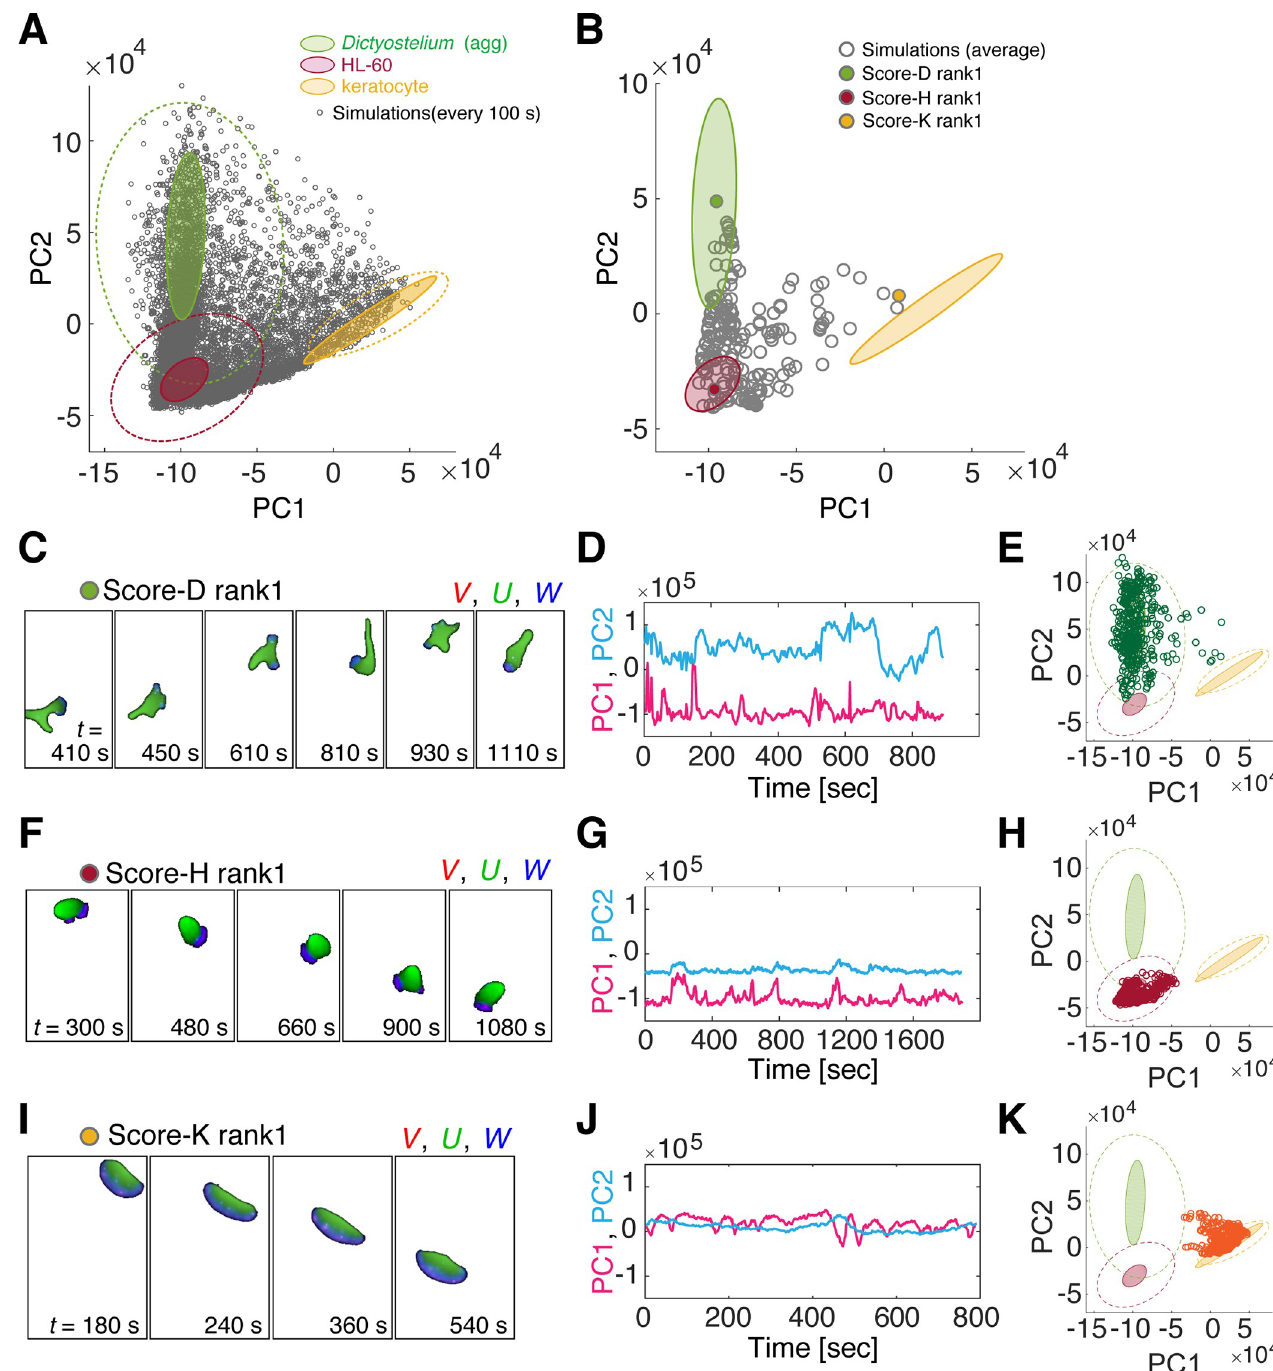
Fig 3. Mapping of morphology features between simulated and real cell data confirms critical parameters that define the morphology type. (A, B) Mapping of simulated cell morphology from the 228 parameter sets (Grey open circle: subsampled time series (A) and time averages for 2 to 4 independent runs (B). Filled circle: simulations with the highest similarity to aggregation-stage Dictyoselium -rank1 (B, green), HL-60 (B, red) and fish keratocyte (B, orange). (B) The 95% confidence ellipses of the trained datasets (aggregation-stage Dictyostelium dark green (dark green), HL-60 (dark red) and fish keratocyte (yellow) in Fig 1B (A, B) are shown for reference. (C-K) Snapshots and the feature scores of the top-ranked simulations; aggregation-stage Dictyostelium (C-E), HL-60 (F-H) and fish keratocyte (I-K). See Table N in S1 Text for parameter values.